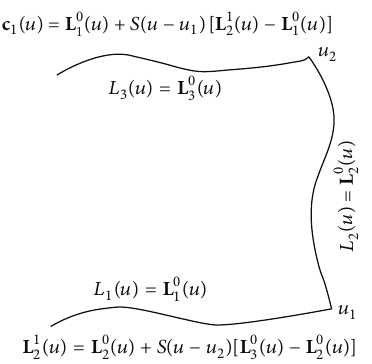
Figure 1: c 1 (𝑢) joining 𝐿 1 (𝑢) , 𝐿 2 (𝑢) , and 𝐿 3 (𝑢) for 𝑁 = 9 . c (𝑢) = L 3 (𝑢) = L 0 (𝑢) + 𝑆(𝑢 − 𝑢 1 ) [ L 2 11 1